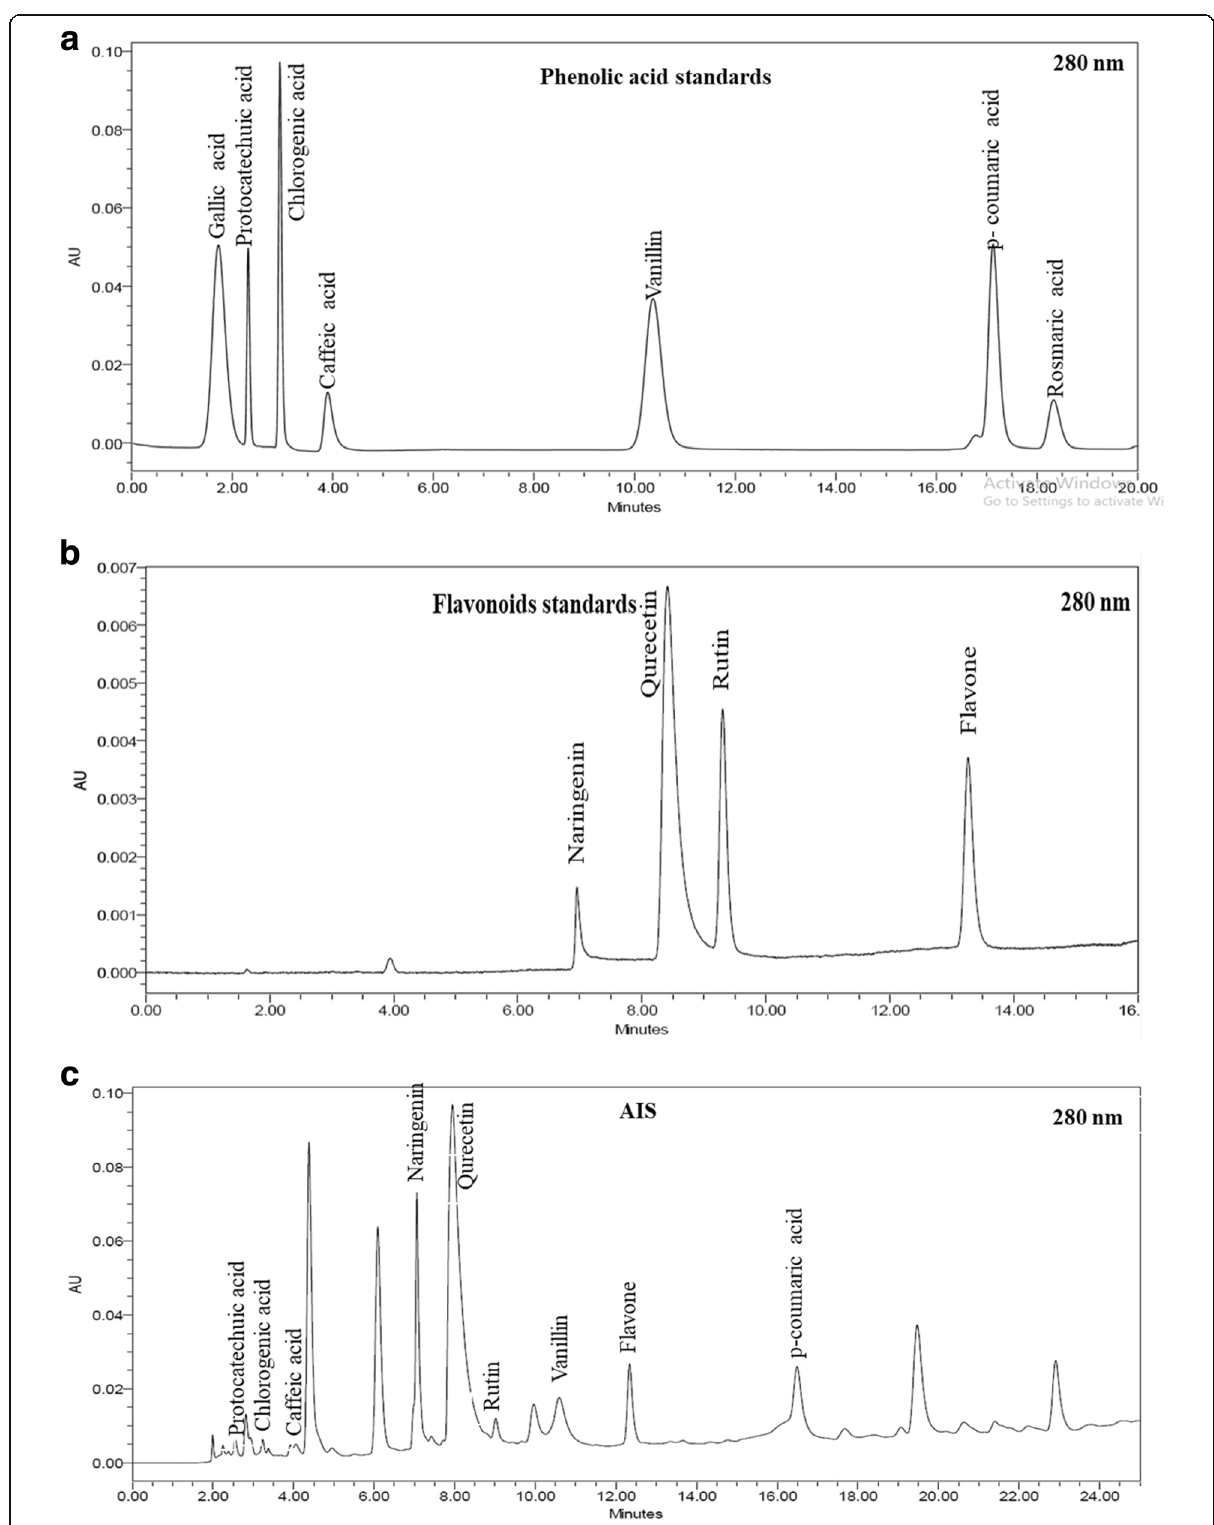
Fig. 3 HPLC profiling of polyphenolic compounds identified in